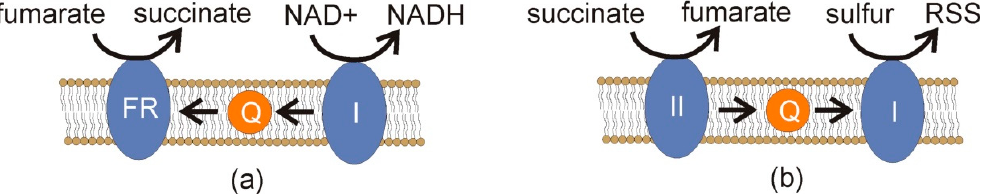
Figure 4. Simplified schemata of a scenario for RSS formation under anaerobic conditions. ( a ) As part of the reductive branch of malate dismutation [16], NADH is oxidized to NAD + by complex I (I) of the electron transport chain (Figure 3). Electrons are carried by rhodoquinone (Q) to fumarate reductase (FR), reducing fumarate to succinate. ( b ) If succinate accumulates, it can inhibit the process in ( a ) and donate electrons to complex II (II) of the electron transport chain, resulting in reverse electron transport in which ubiquinone (Q) carries electrons to complex I (I), and these electrons are ultimately scavenged by sulfur to form RSS. Paralleling Figure 2, such RSS formation would select for exporting succinate and related products to avoid this sort of end-product inhibition.